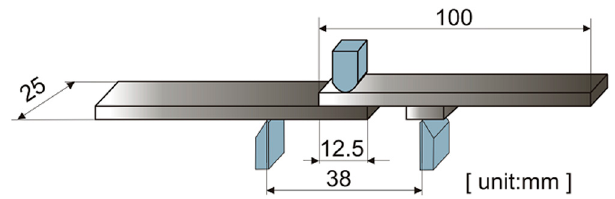
Figure 6. Schematic drawing of flexural test of a welded specimen.